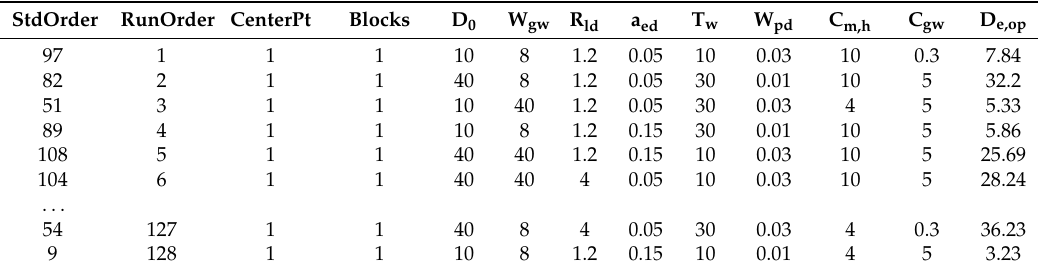
Figure 3. Main effects plot for optimum replaced grinding wheel diameter. The influences of input parameters on the optimal replaced diameter are illustrated in Figure 4. From this figure, the optimal replaced diameter 𝐷 (cid:3032),(cid:3042)(cid:3043) is powerfully contingent on the original wheel